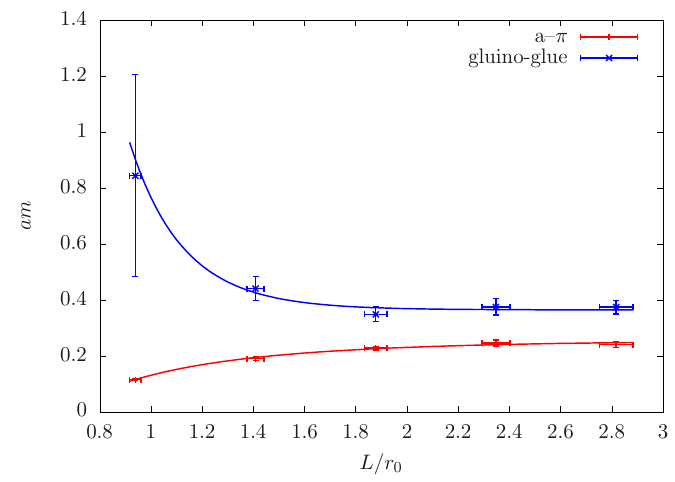
Figure 8. The adjoint pion and gluino-glue mass from simulations at β = 5 . 6, κ = 0 . 1660 on lattices of size 8 3 × 32, 12 3 × 32, 16 3 × 32, 20 3 × 40, and 24 3 × 48. These data indicate the magnitude of finite size effects. The results have been fitted assuming a finite size correction proportional to exp( − αL ) /L with some positive coefficient α .